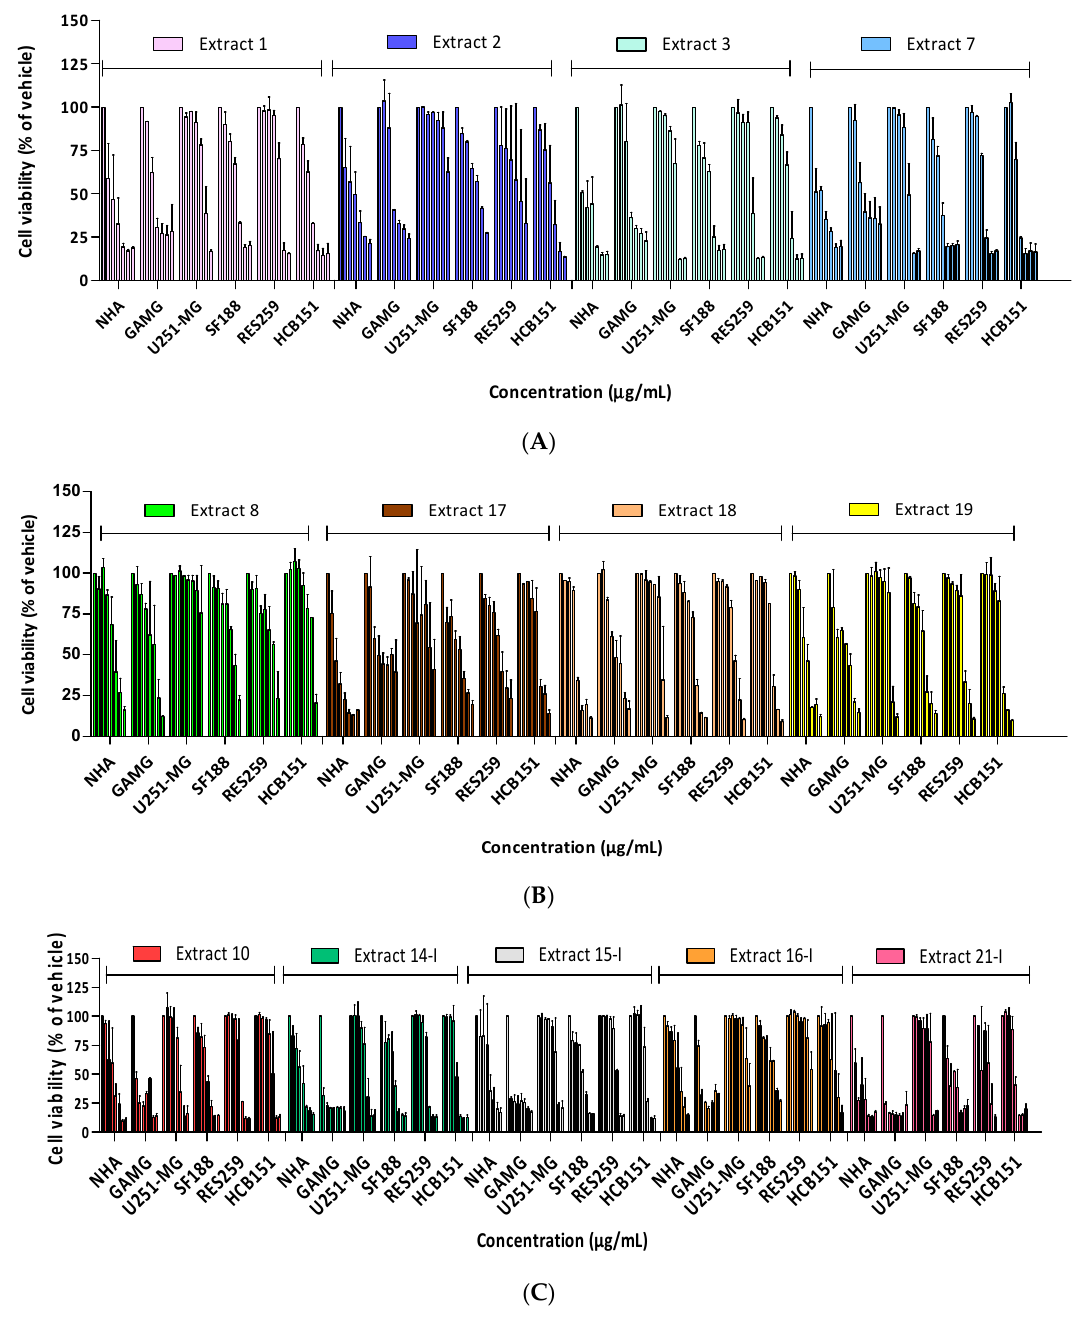
Figure 1. Time and concentration cytotoxic effect of the crude extract’s exposure on the human cancer cell line. Cells (5 × 10 3 ) were plated into 96-well plates, exposed to the vehicle (1% DMSO) or increasing concentrations of the samples ( A ) crude extracts (1, 2, 3 and 7) 12 µg/mL to 300 µg/mL, ( B ) crude extracts (8, 17, 18 and 19) 1.5 µg/mL to 300 µg/mL and ( C ) crude extracts (10, 14I, 15I, 16I and 21I) 3 µg/mL to 300 µg/mL. Cell viability was measured with an MTS assay after 72 h of extract treatment. The cell viability of the untreated cells was regarded as 100%. The results shown are the means ± S.D of three independent experiments.